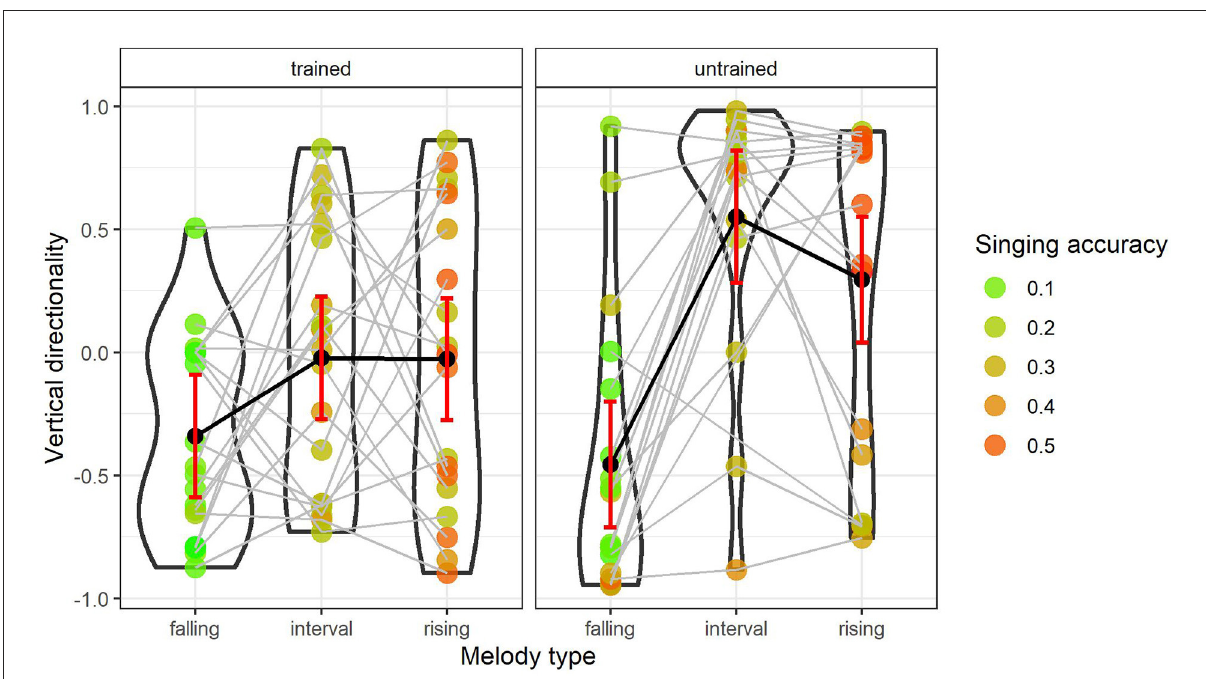
FIGURE2 Estimations for vertical directionality. The red bars indicate 95% confidence intervals and the dots represent the individual data points (head movement slope per melody) per condition in each of the two groups. The colors of the dots represent the singing accuracy: green is more accurate and red is less